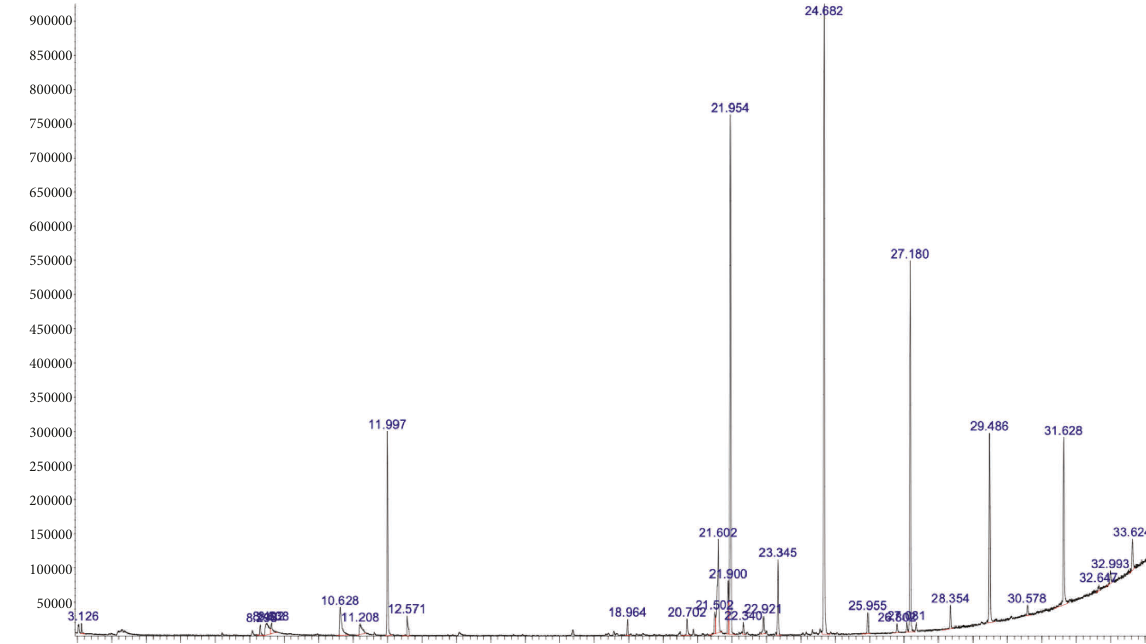
Figure 6: Chromatogram of volatile compounds of R. damascena flower